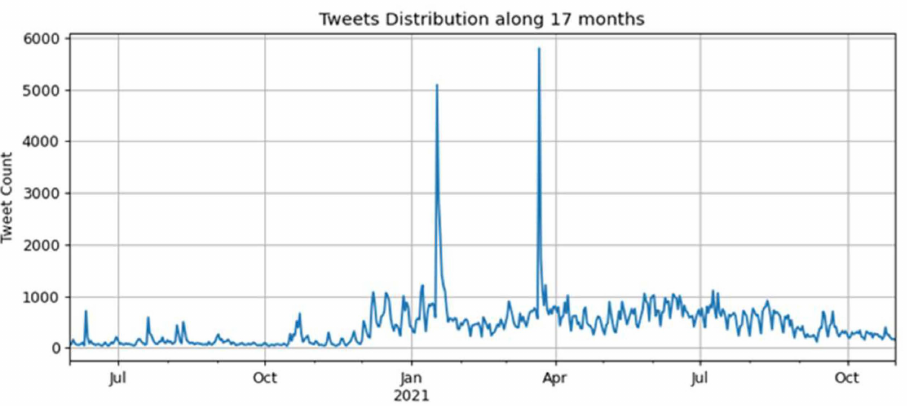
Figure 2. Time series of tweets over seventeen months, from June 2020 to October